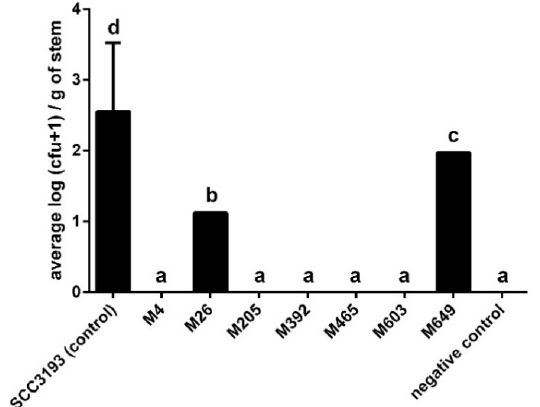
Figure 7. Population size of WT P. parmentieri strain SCC 3197 and seven phage-resistant mutants within stems of potato plants after inoculation into soil. Results considered significant at p = 0.05, and the pair-wise differences were obtained using the t -test. The means that do not share the same letters above each bar differ. Vertical lines represent standard deviation (SD).